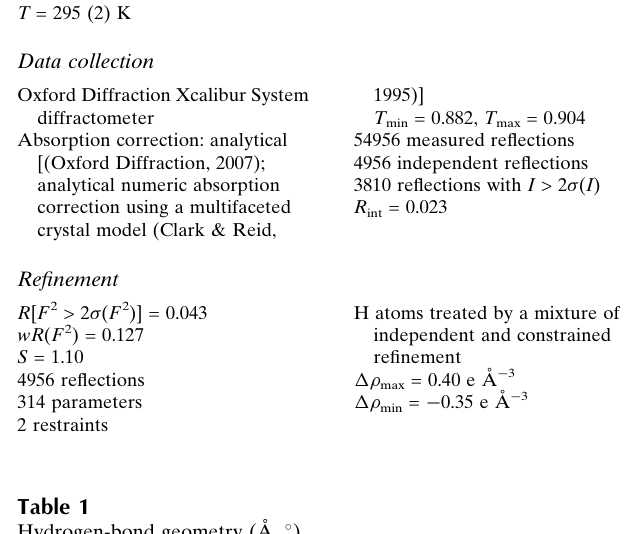
Absorption correction: analytical [(Oxford Diffraction, 2007); analytical numeric absorption correction using a multifaceted